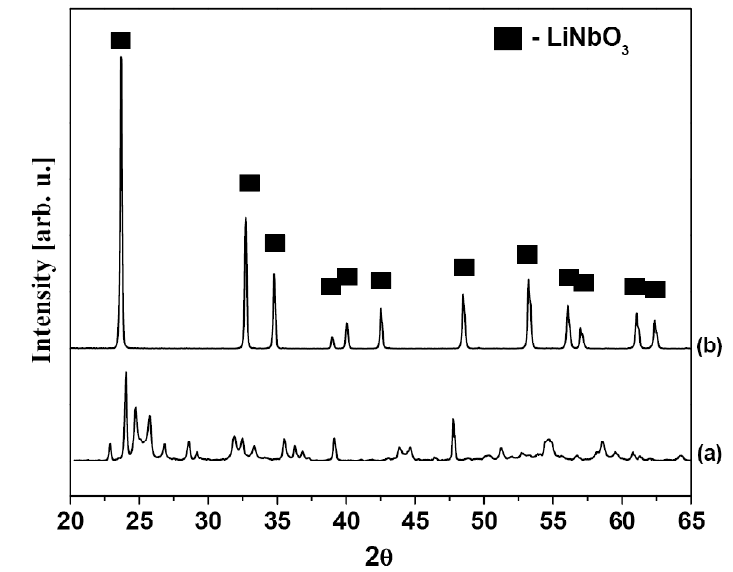
Figure 1. XRD patterns of Nb